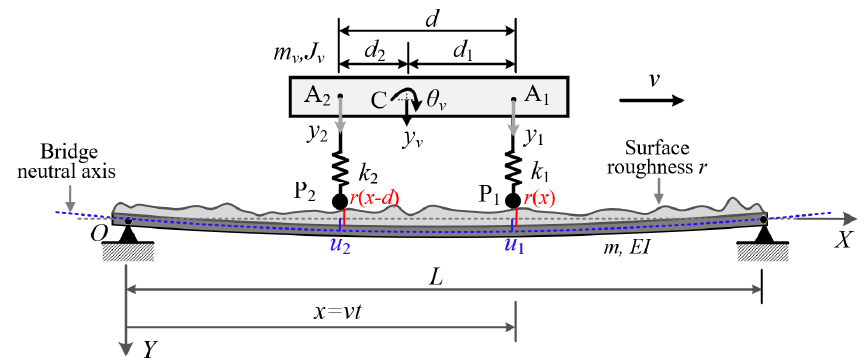
Figure 2. Vehicle–bridge interaction model with roughness.